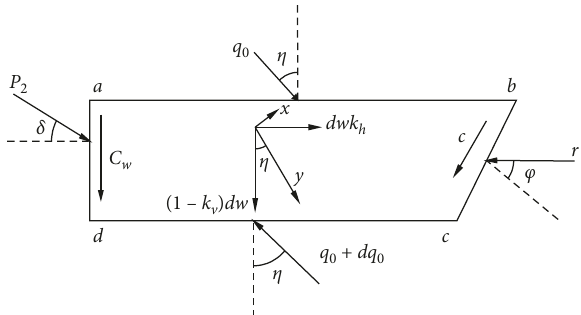
Figure 3: Force analysis of passive earth pressure of horizontal microelement soil